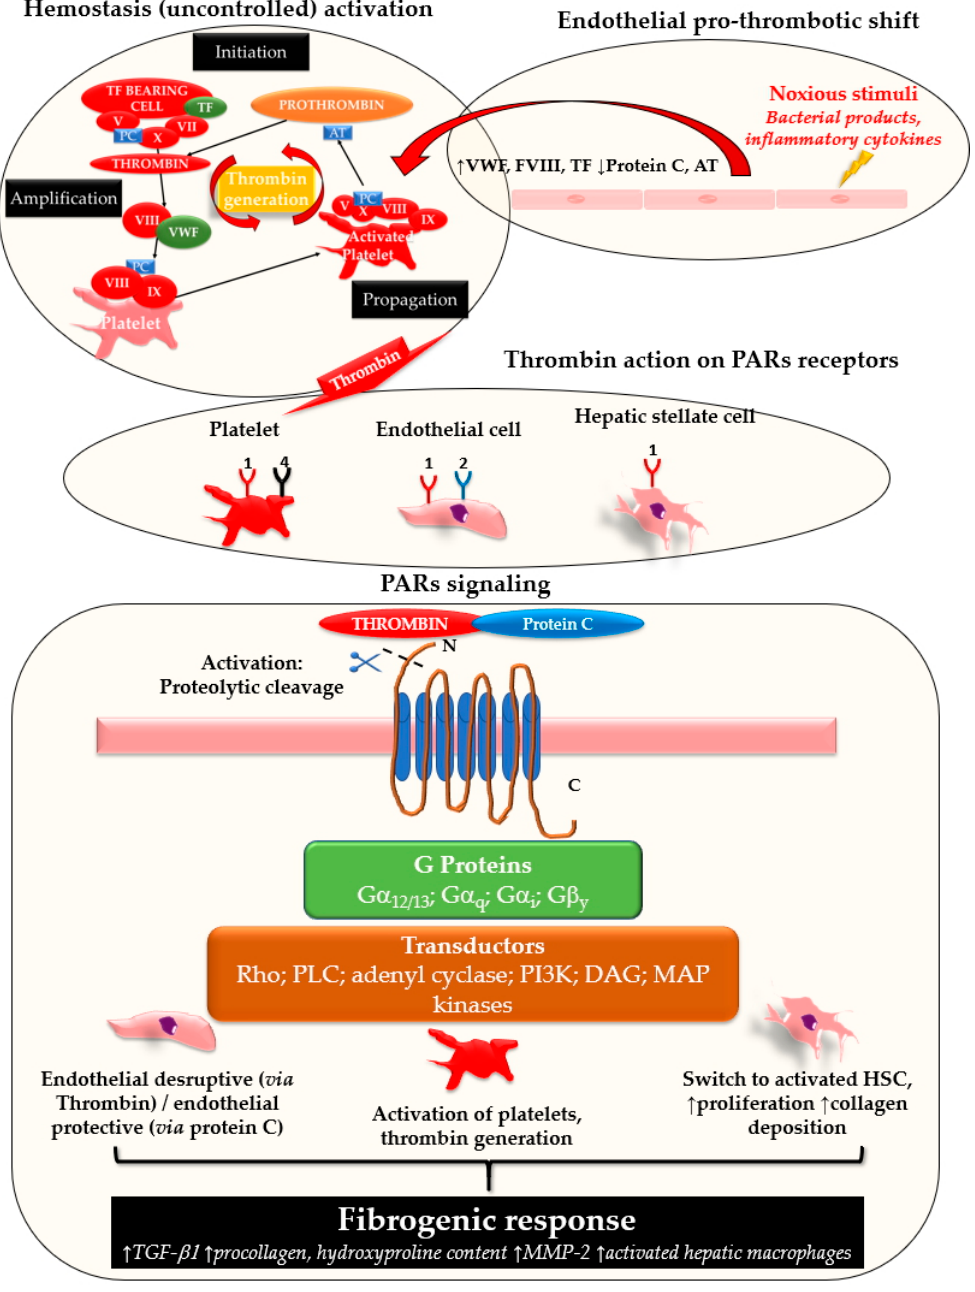
Figure 1 . Schematic representation of PAR signaling. Figure 1. Schematic representation of PAR